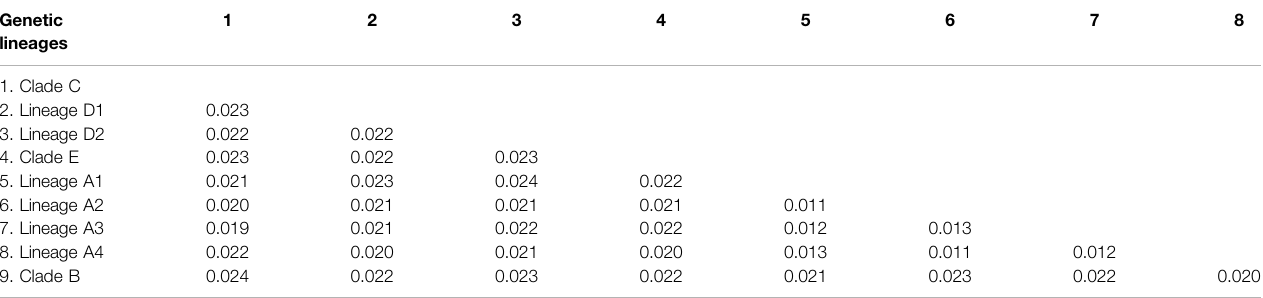
TABLE 5 | K2P distances for MOTUs within the T. albomarginatus s.l. based on the Cyt. b gene.